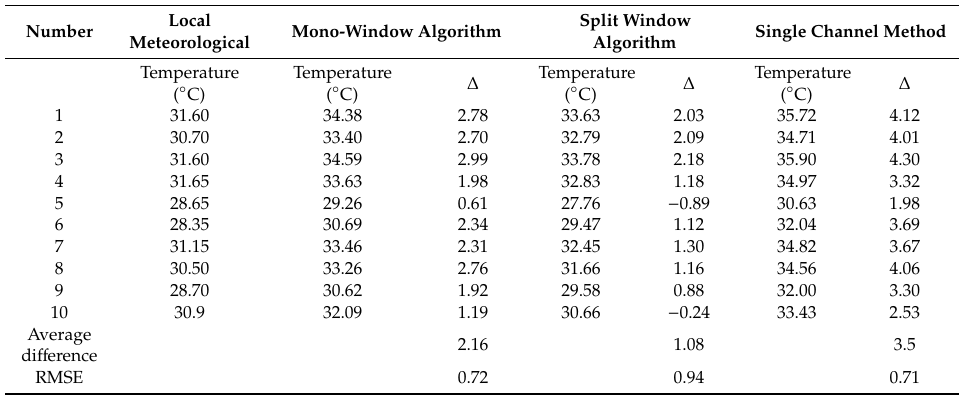
Table 8. Comparison of the calculation results of the three algorithms with local meteorological data.